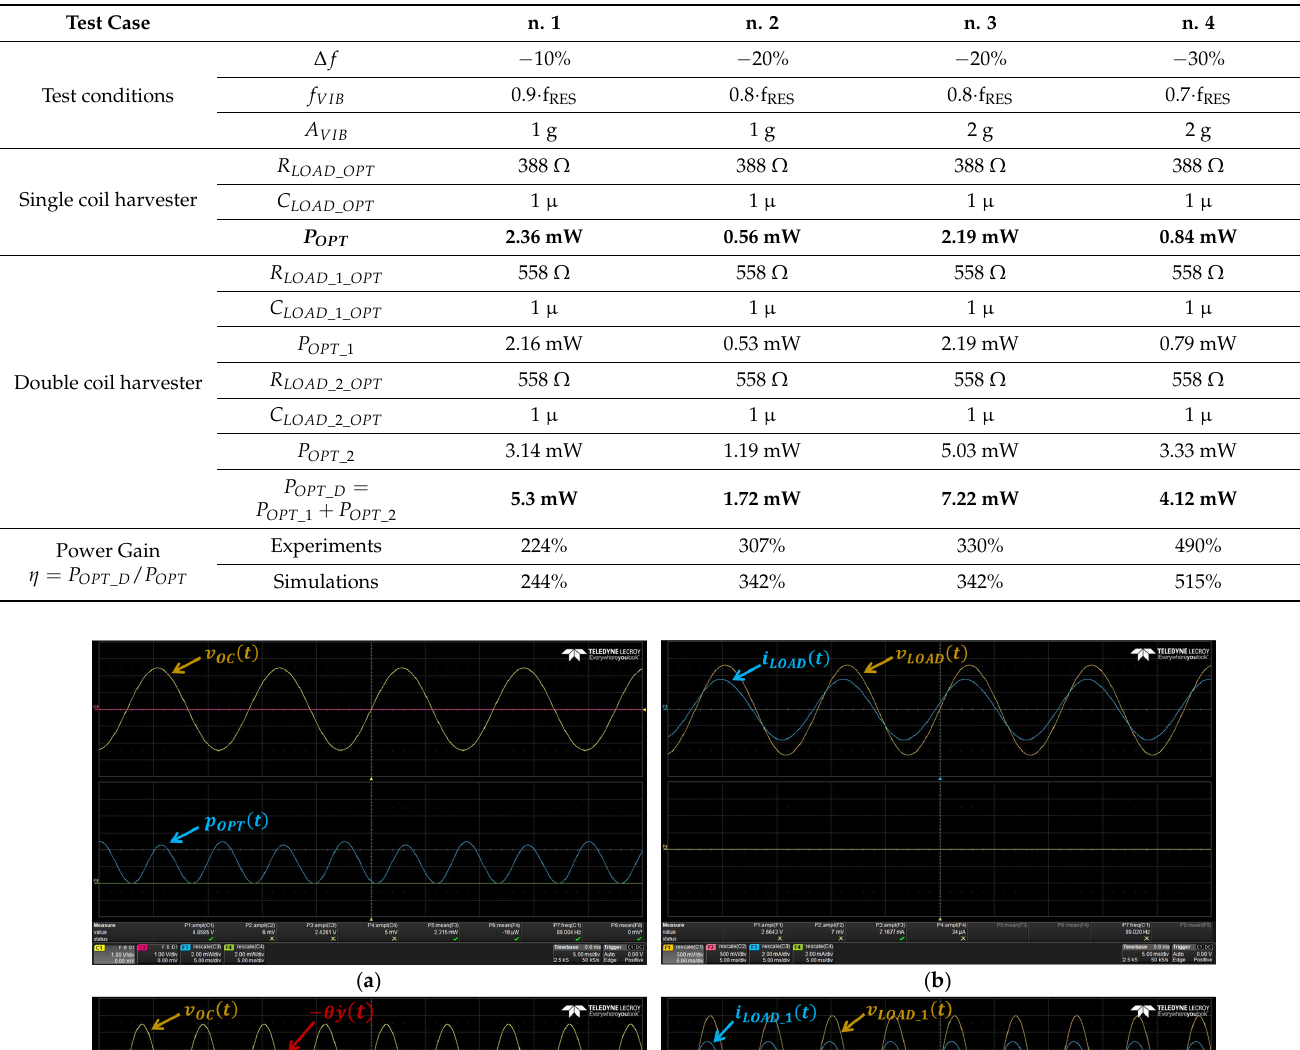
Table 2. Experimental tests on the electrical circuits of single coil and double coil harvesters.